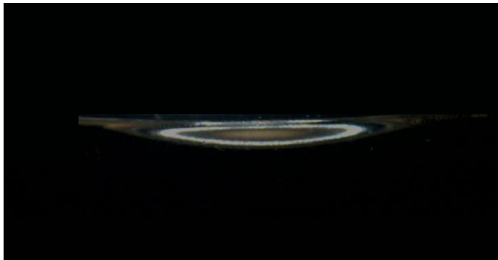
Figure 3. Experimental results of the gas jet forming using the self-similarity region.